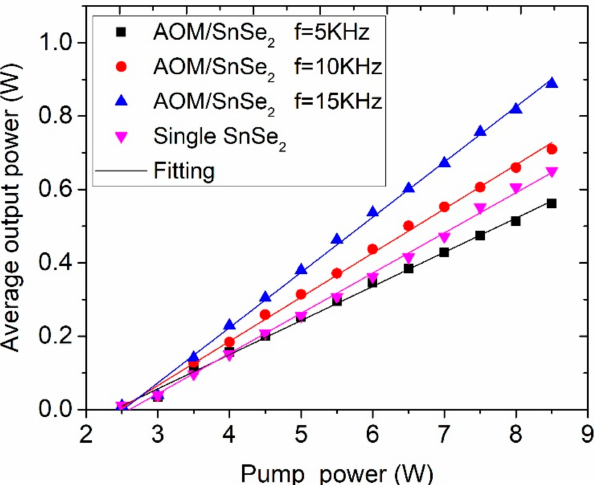
Figure 4. The variation curves of average output power for QML lasers with different modulation methods.